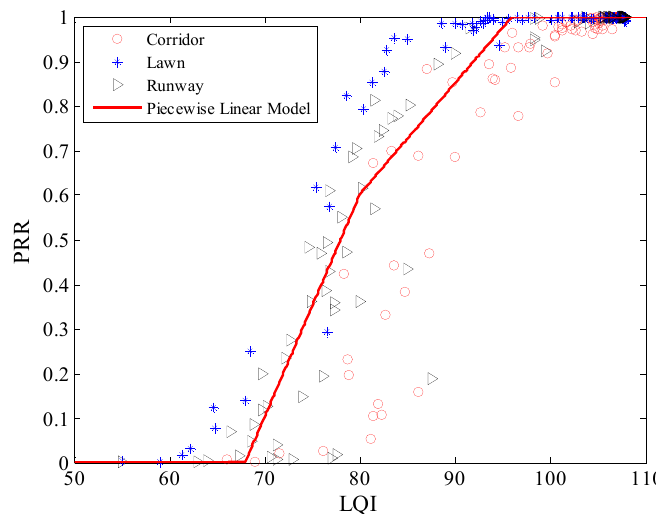
Figure 23. E ff ects of the piecewise linear model in di ff erent environments. Figure 23. Effects of the piecewise linear model in different environments.